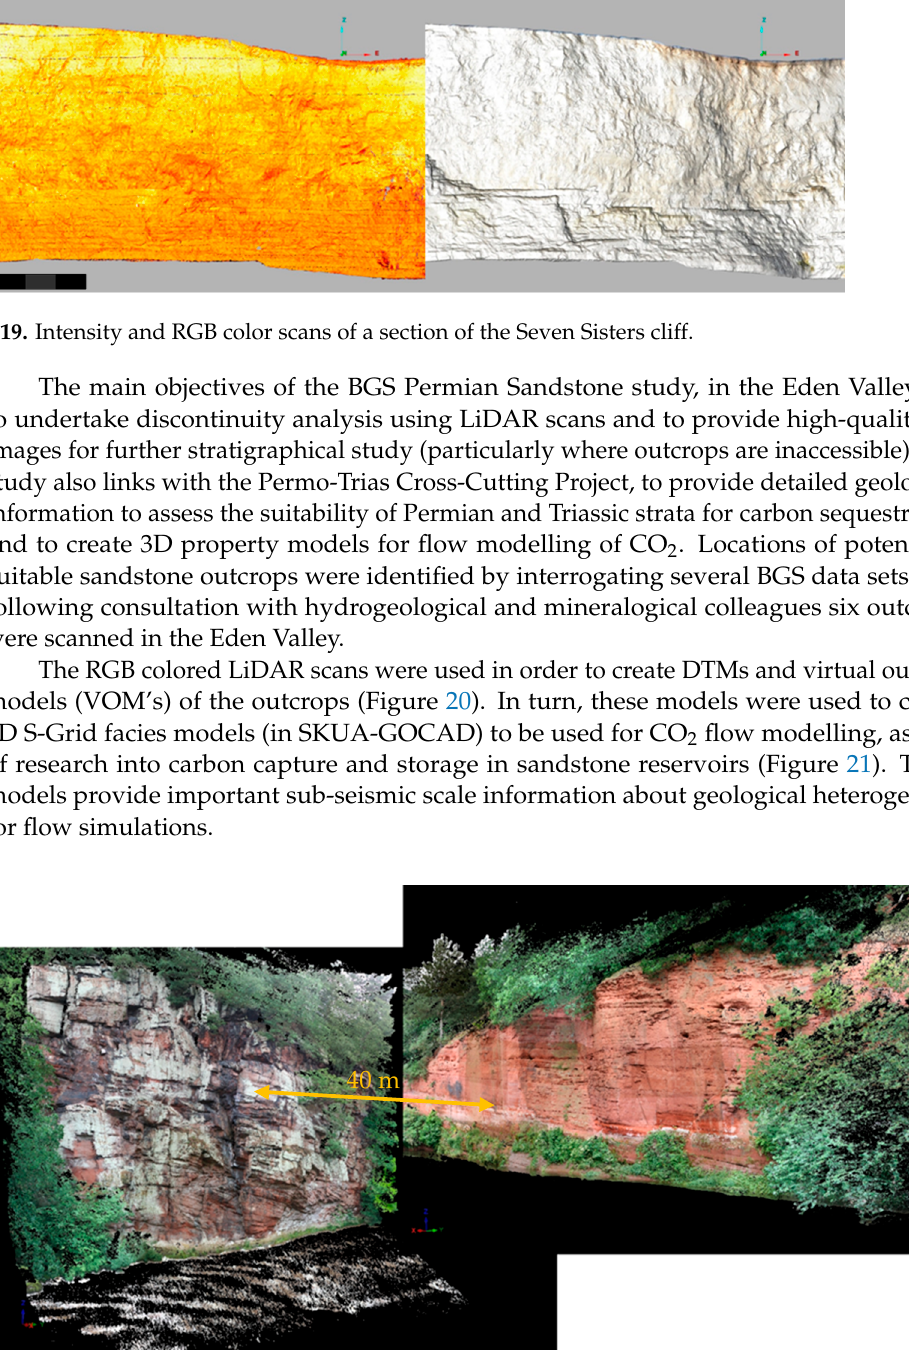
Figure 18. Seven Sisters cliff, East Sussex (4 km long × 75 m high).